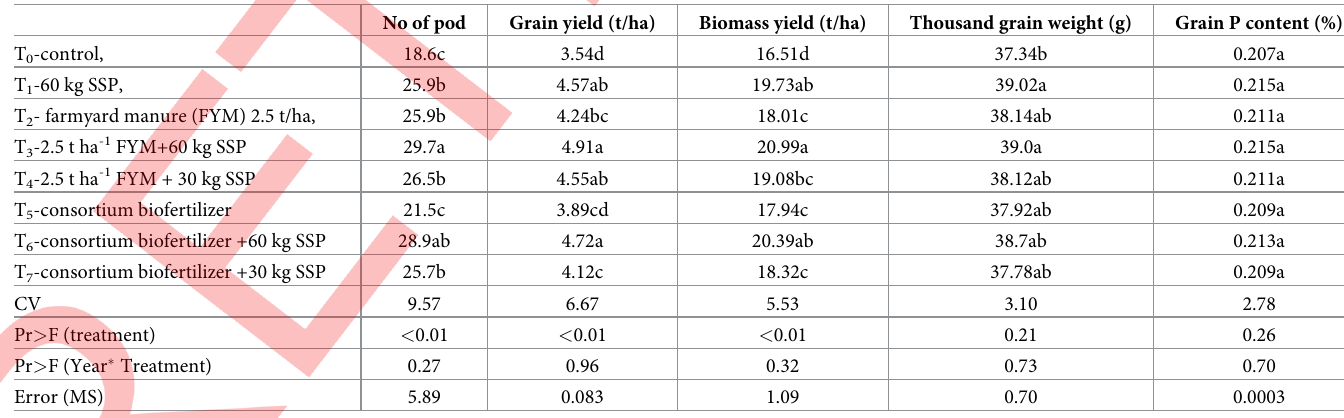
Table 2. Yield and yield attributes under different phosphorus levels, farmyard manure, and biofertilizer treatments. No of pod Grain yield (t/ha) Biomass yield (t/ha) Thousand grain weight (g) Grain P content